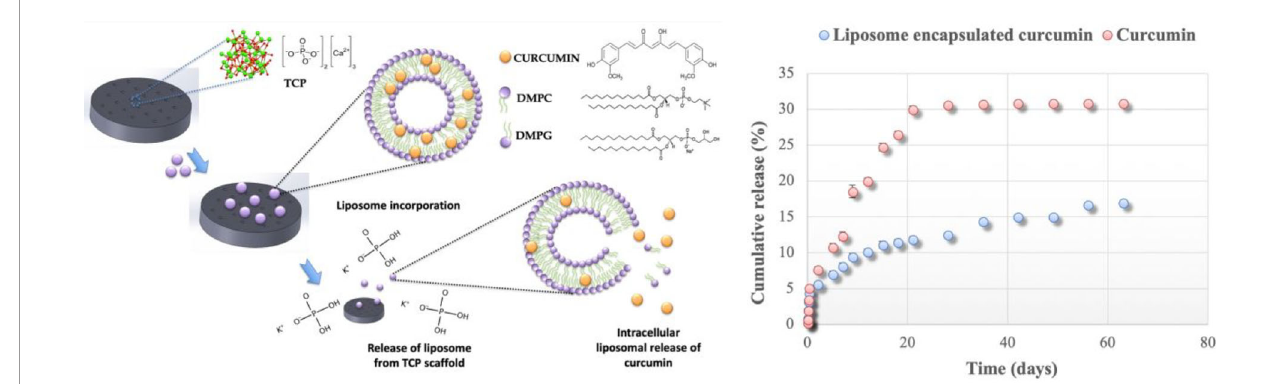
FIGURE 2 | 3DP scaffolds containing DMPC and DMPG formed liposomes loated with curcumin. In the presence of a buffer medium or an extracellular medium, liposome released, followed by curcumin released from the liposome. Reproduced from (12) with permission from ACS Appl Mater